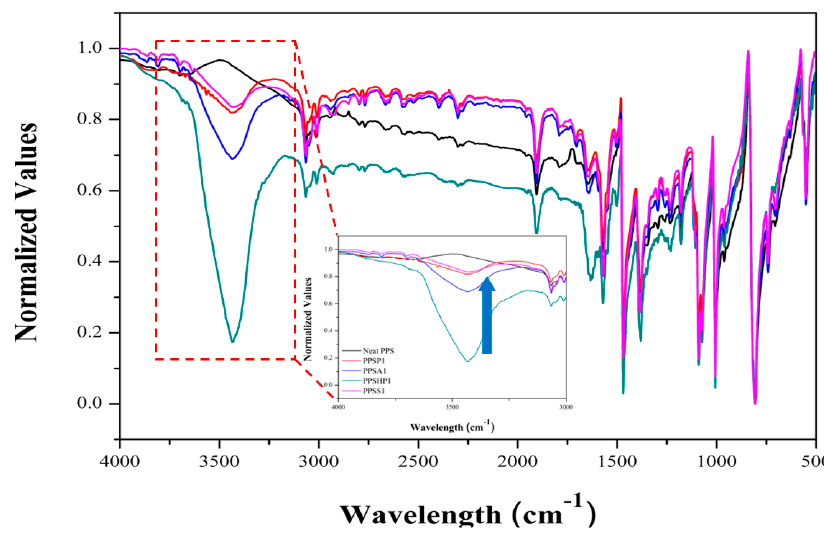
Figure 2. Normalized FT-IR spectra of the PPS/MWCNTs composites (the inset image is an enlarged spectra of the PPS/MWCNTs composites ranged from 3000 to 4000 cm − 1 ).